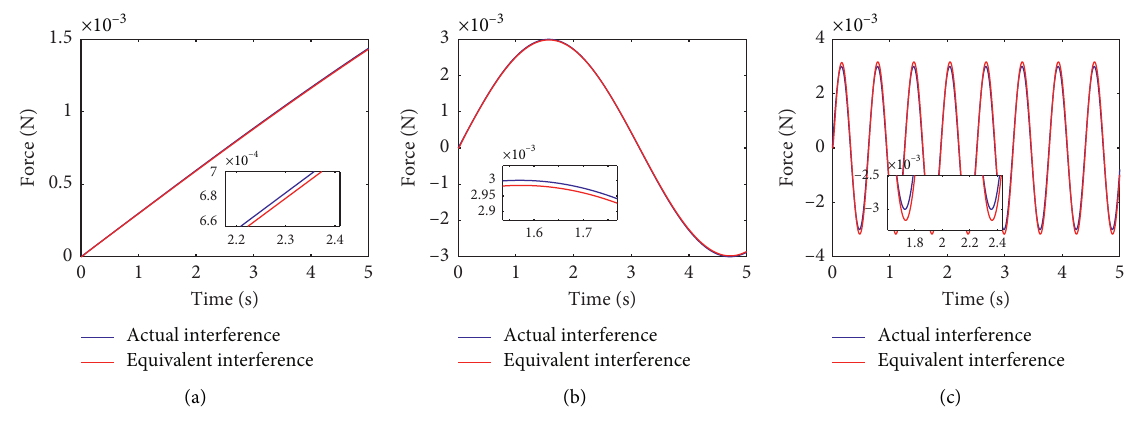
f f dx , (b) dy , and (c) dz